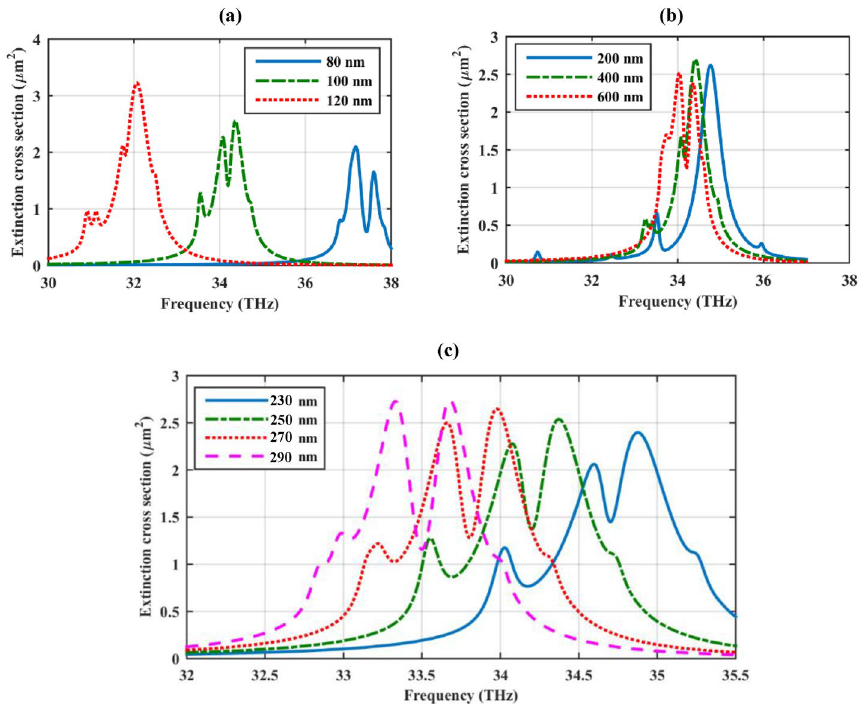
Figure 6. The impact of the geometrical parameters on the modulation of the Fano dips ( a ) the radii of the spheres ( r s ) ( b ) the radius of the cylinder ( r c ) and ( c ) the periodicity along the cylinder axis. The initial design parameters are as follows: r